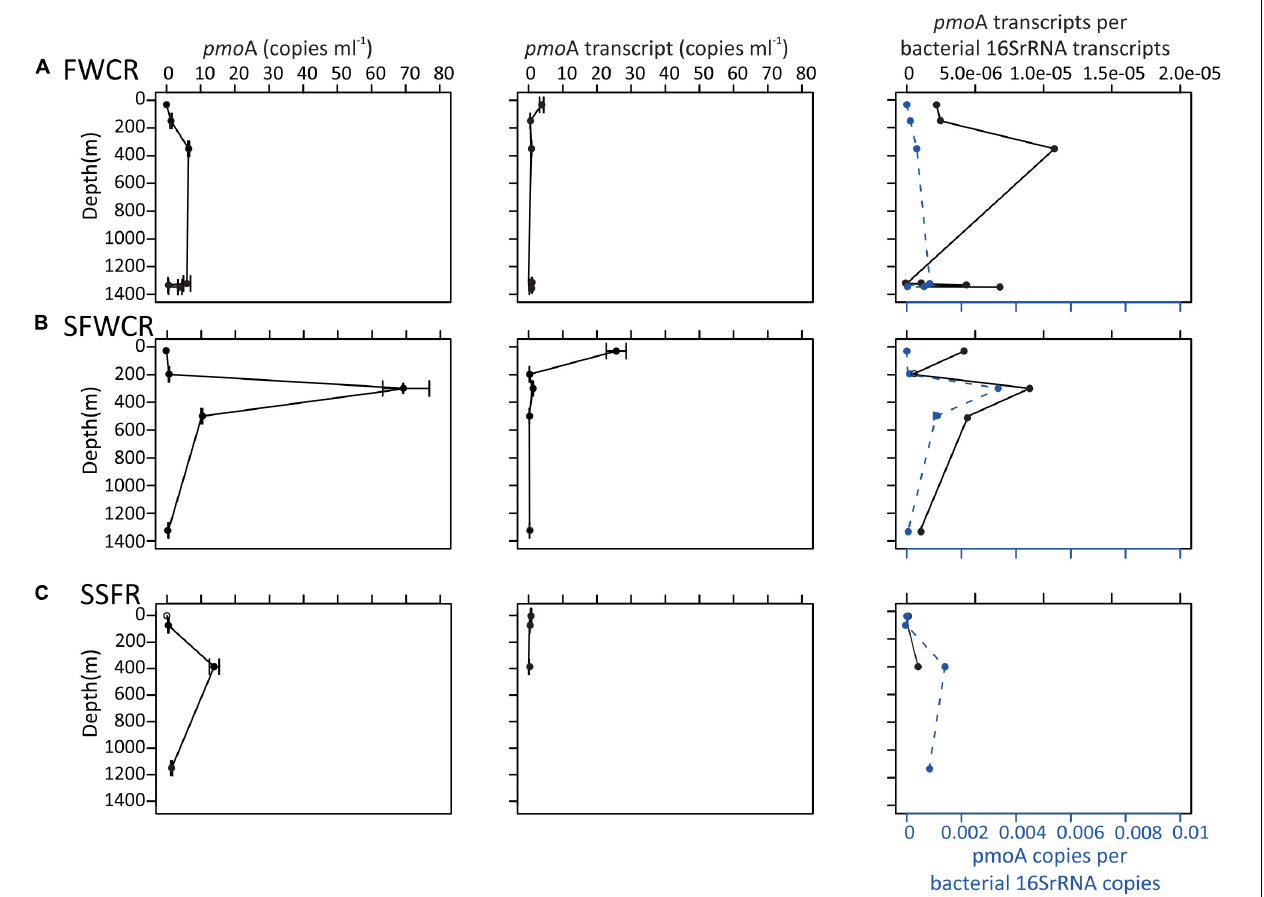
FIGURE 9 | pmo A gene and transcript abundance in copies per milliliter of seawater, and the normalized pmo A gene to the abundance of 16S rRNA gene at the indicated depth above (A) FWCR, (B) SFWCR, and (C) SSFR. The number of copies and error bars represent the average and standard deviations calculated from four measurements.